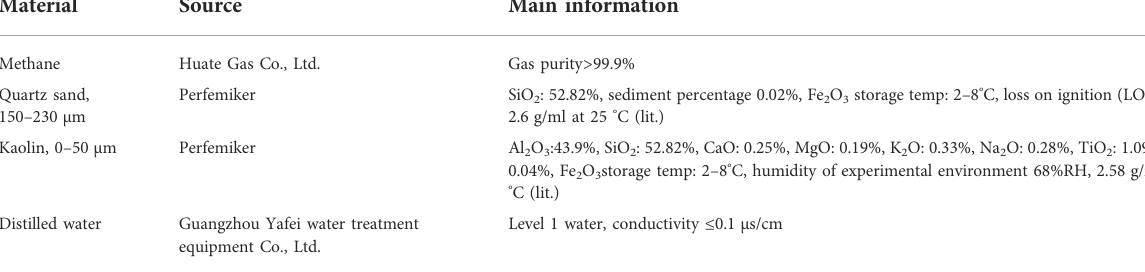
TABLE 2 Information of experimental materials for hydrate-bearing